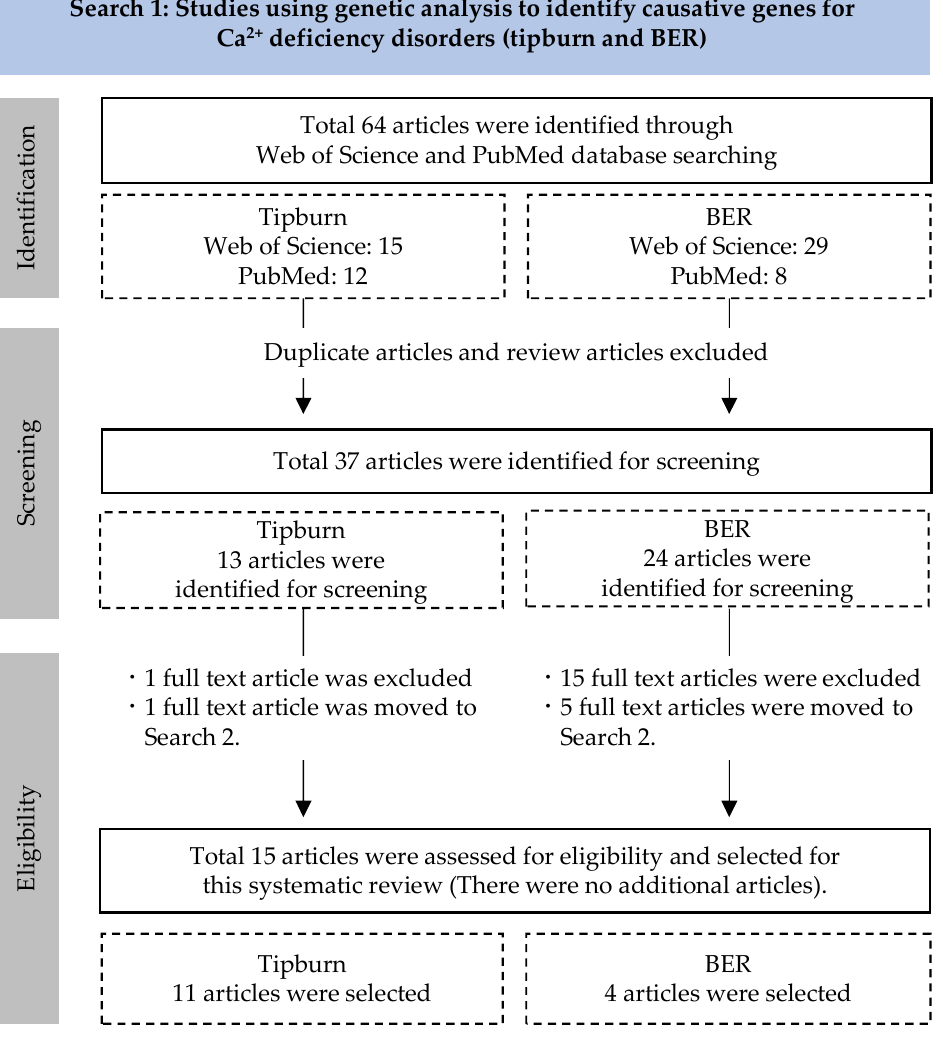
Figure 1. Systematic review flow chart for Search 1.